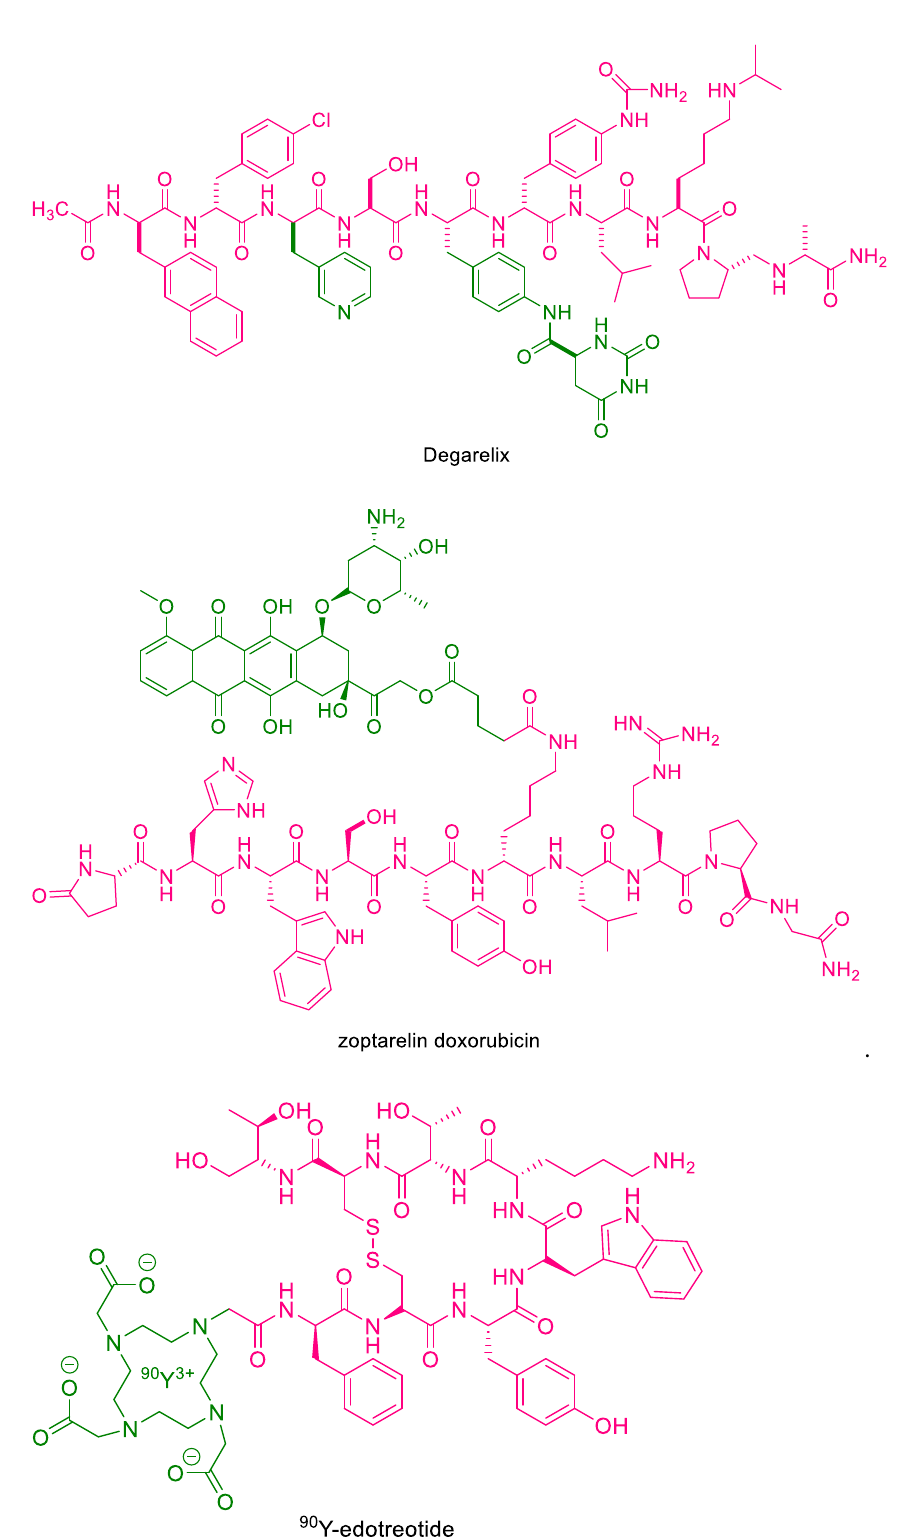
Figure 9. Some of the drugs in the market resulting from hybridisation of small molecules to pep-